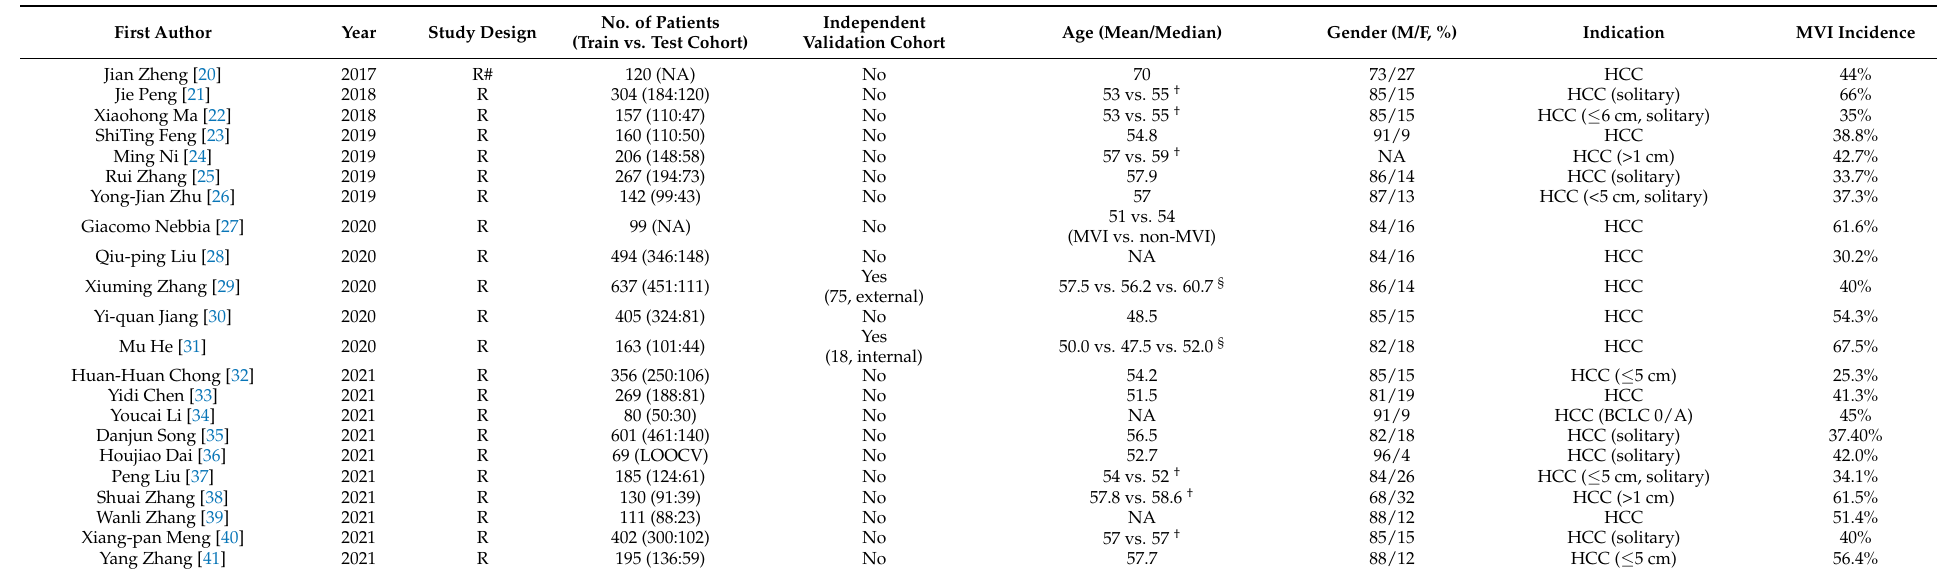
Table 1. Study and patient